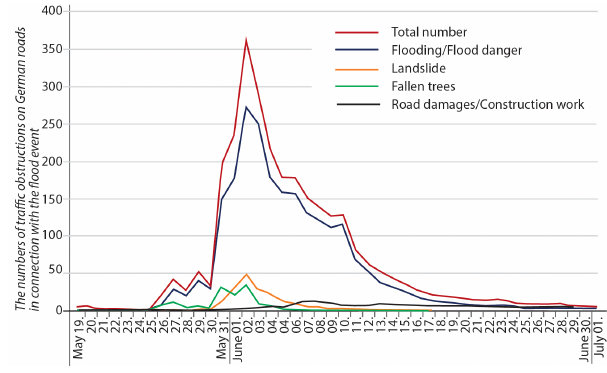
Figure 6. Chronological sequence of the number of traffic obstruc- tions on German roads related to the flood event in the period from 19 May to 1 July 2013, subdivided into causes and as a total